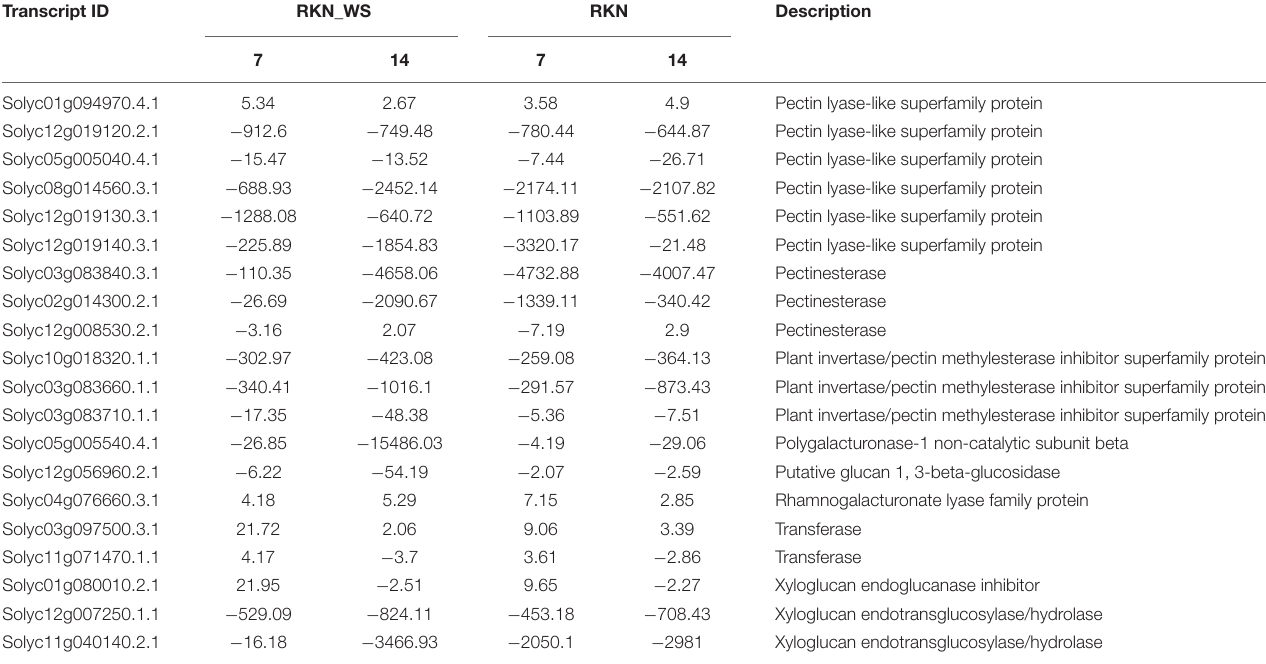
and downregulated at 14 dpi, whereas Solyc12g008530.2.1 (downregulated at 7 dpi) was upregulated at 14 dpi ( Figure 6